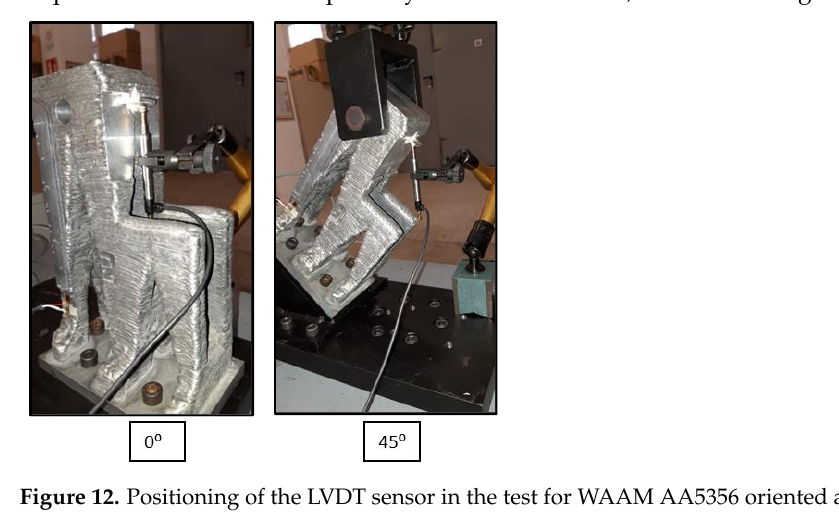
Figure 13. Deformation at different loadings under tensile and compression tests compared with the FEM results oriented at 0° and 45° on PLA and AA5356 turrets. It is clear from the graph that, at 0° deformation under tensile and compression tests, both materials are close to the admissible limit. At 45°, deformation is larger in both ma- terials. So, it is concluded that the parts built from additive manufacturing go under a higher deformation when the load is applied at 45°, which is due to the anisotropy of the material in the different directions, and it is clearly captured by the FEM simulation re- sults. This comparison between the FEM and experimental tests shows that FEM model allow us to understand the behavior of the mechanical properties of different materials. This kind of validation helps the designer to choose the different additive manufacturing